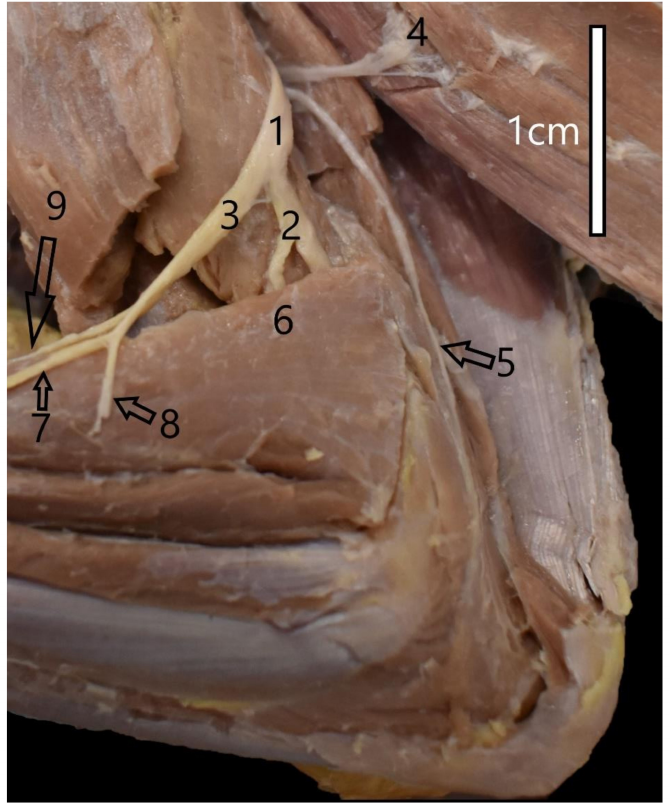
Figure 1. Innervation of the left arm of the common raccoon dog ( Nyctereutes procyonoides ). 1—Radial nerve; 2—Deep branch of the radial nerve; 3—Superficial branch of the radial nerve; 4—Branch of the radial nerve to lateral head of the triceps muscle of the arm; 5—Branch of the radial nerve to anconeus muscle; 6—Branch of the radial nerve to brachioradialis muscle; 7—Lateral branch of the superficial branch; 8—Lateral antebrachial cutaneous nerve; 9—Medial branch of the superficial